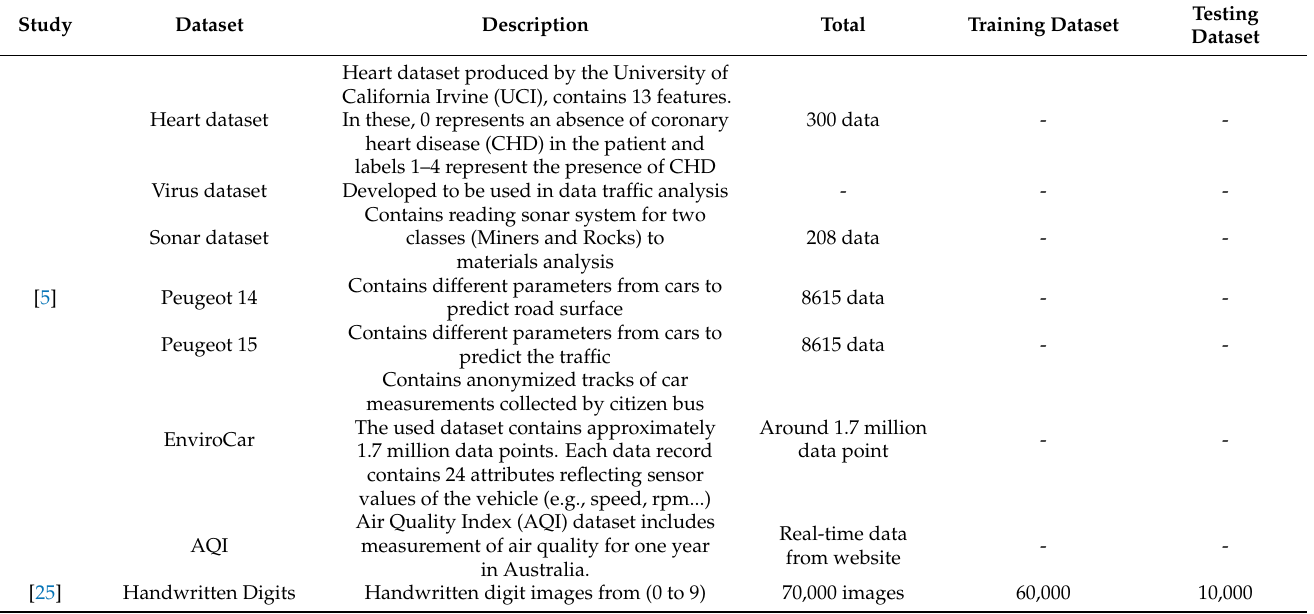
Table 5. Summary of dataset descriptions used in previous TinyML-based